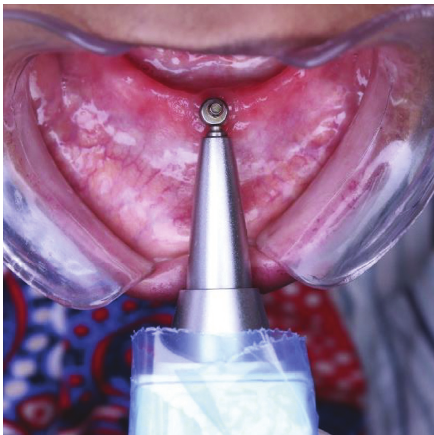
Figure 3: Measurement of Periotest values (PTV) of attachment using Periotest